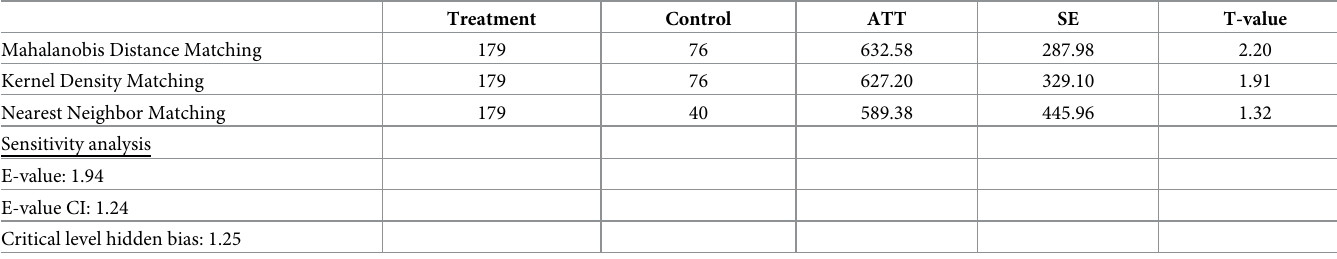
Table 6. ATT comparison between good vision and poor vision groups with PSM and MDM.